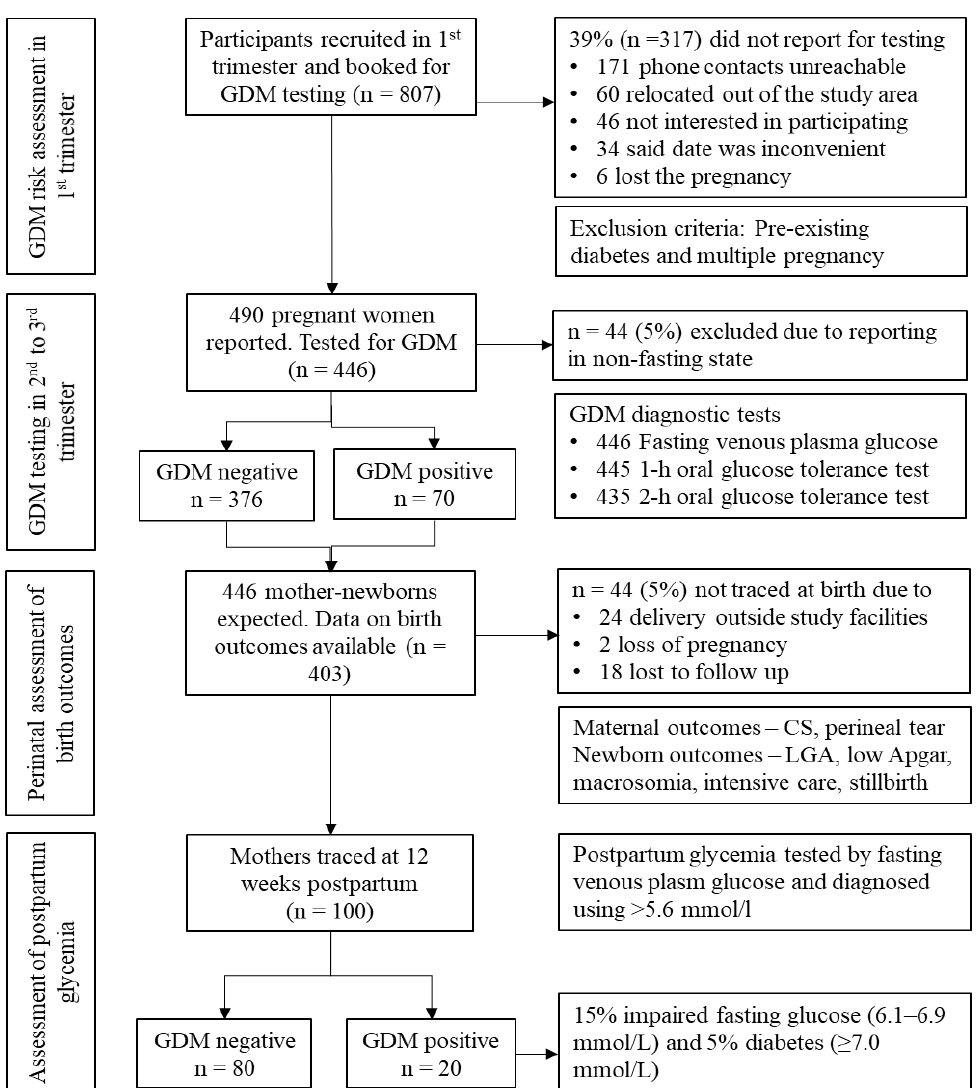
Figure 3. Number of participants followed-up at each stage of the study. Note: n , number of participants; GDM, gestational diabetes mellitus; CS, cesarean section; LGA, large-for-gestational-age.